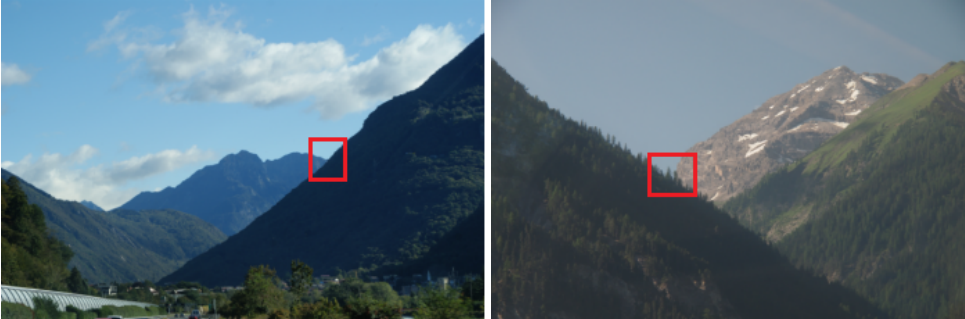
Figure 8. The lapel point of a skyline: ( left ) left lapel point of skyline; and ( right ) right lapel point of skyline.